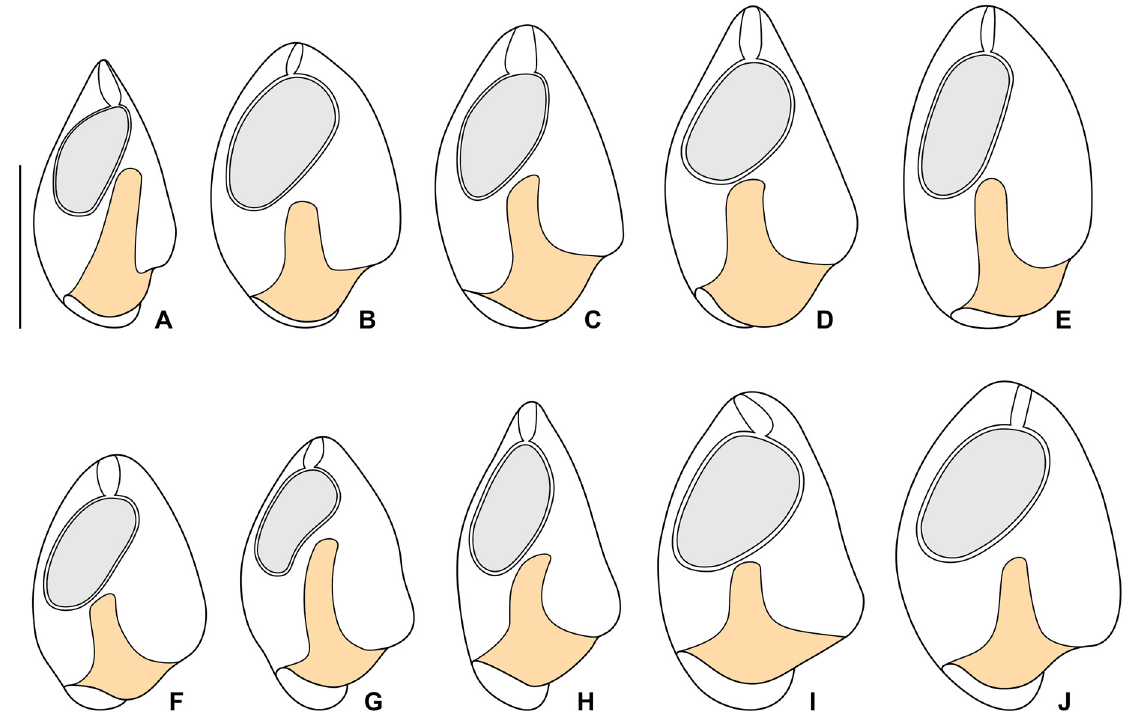
Fig. 13. Paraclevelandia brevis Kidder, 1937. Thai I specimens isolated from Panesthia angustipennis angustipennis (Illiger, 1801) after protargol impregnation. A–J . Variability of body shape and size as well as of the nuclear (shaded grey) and oral (shaded yellow) apparatus. Scale bar = 20